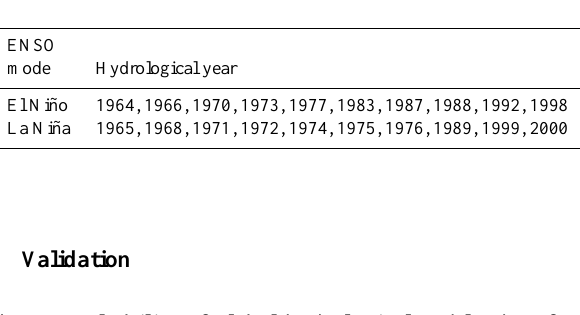
Table 1. Hydrological years categorised as El Niño and La Niña, based on the ENSO classification of the Center for Ocean- Atmospheric Prediction Studies (COAPS) of Florida State Univer- sity